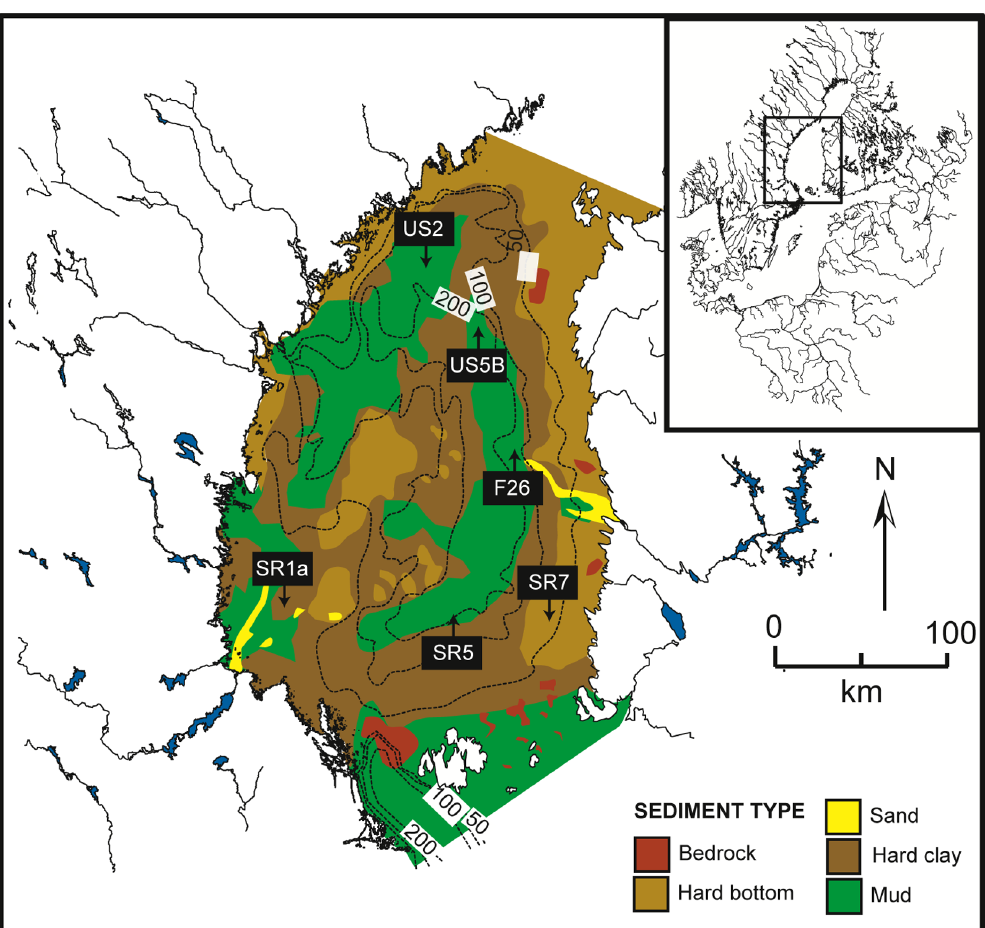
Figure 1. Location map of the study sites in the Bothnian Sea. Site characteristics are given in Table 1. Simplified bathymetric overlay and bottom sediment type are adapted from [73] and [72], respectively.